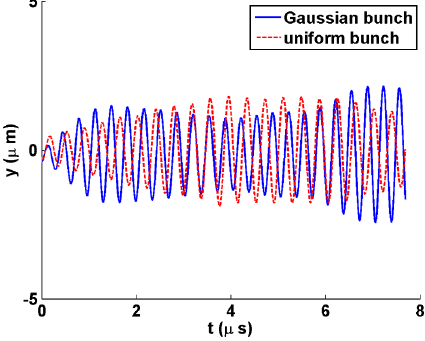
FIG. 4. Vertical oscillation of an ion cloud consisting of H þ 2 ions around the beam potential of a 100 MeV bunch.